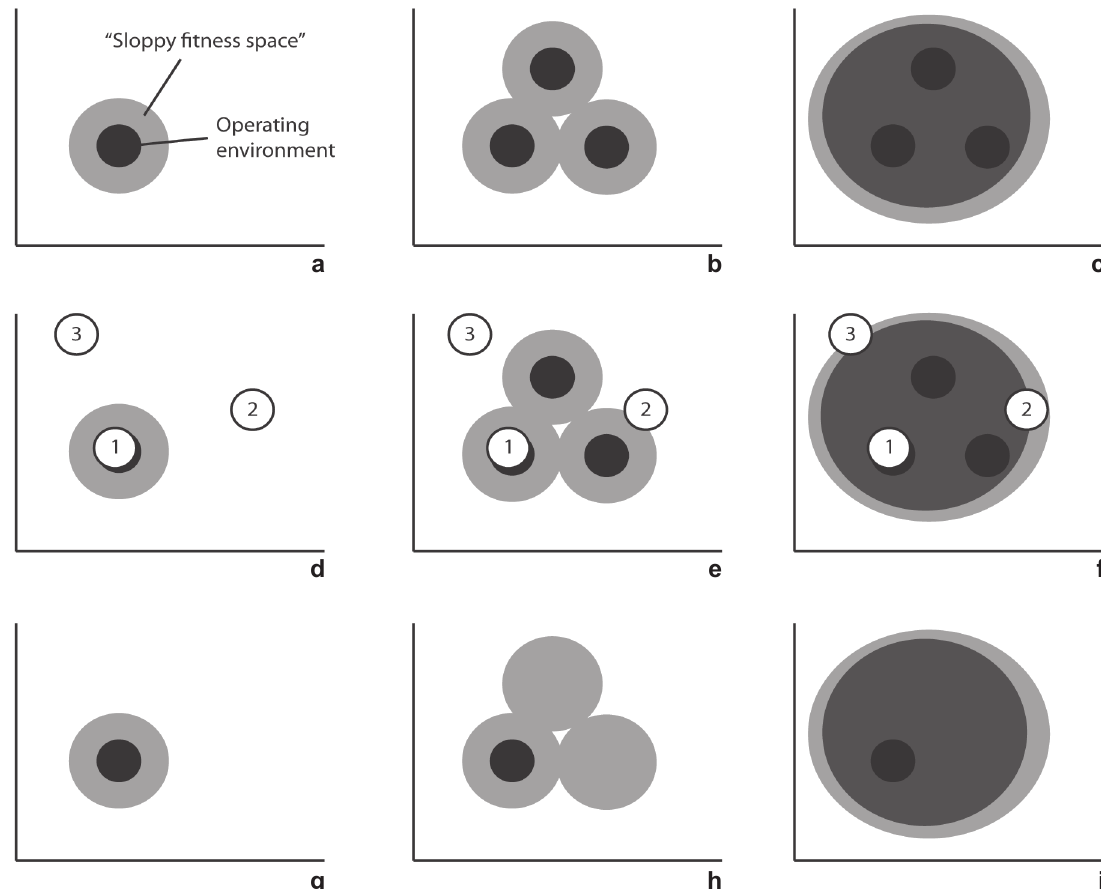
Figure 1. A schematic illustration showing two dimensions of the operative environment associated with fictional host resources (black circles). Sloppy fitness space (see text) can allow realized fitness in an area outside the operative environment to which the parasite is adapted (light grey circles). Panels a , d , and g illustrate a specialist, adapted to a single host resource, panels b , e and h illustrate a polyspecialist that has adapted independently to three different resources, and panels c , f and i illustrate a true generalist with a more general host recognition and tolerance system that allows it to utilize any resource that falls within the dark grey area. The open circles in panels d-f represent three novel resources. The specialist in panel d can colonize resource 1 (which is more or less identical to the ancestral resource) but not resource 2 and 3. The polyspecialist in panel e can colonize resource 1, but also resource 2 that falls within its sloppy fitness space, and the generalist in panel f can colonize all three resources. In panels g-i only one host is available, and all three parasite species will appear to be specialists, but their ecological and evolutionary potential will be very